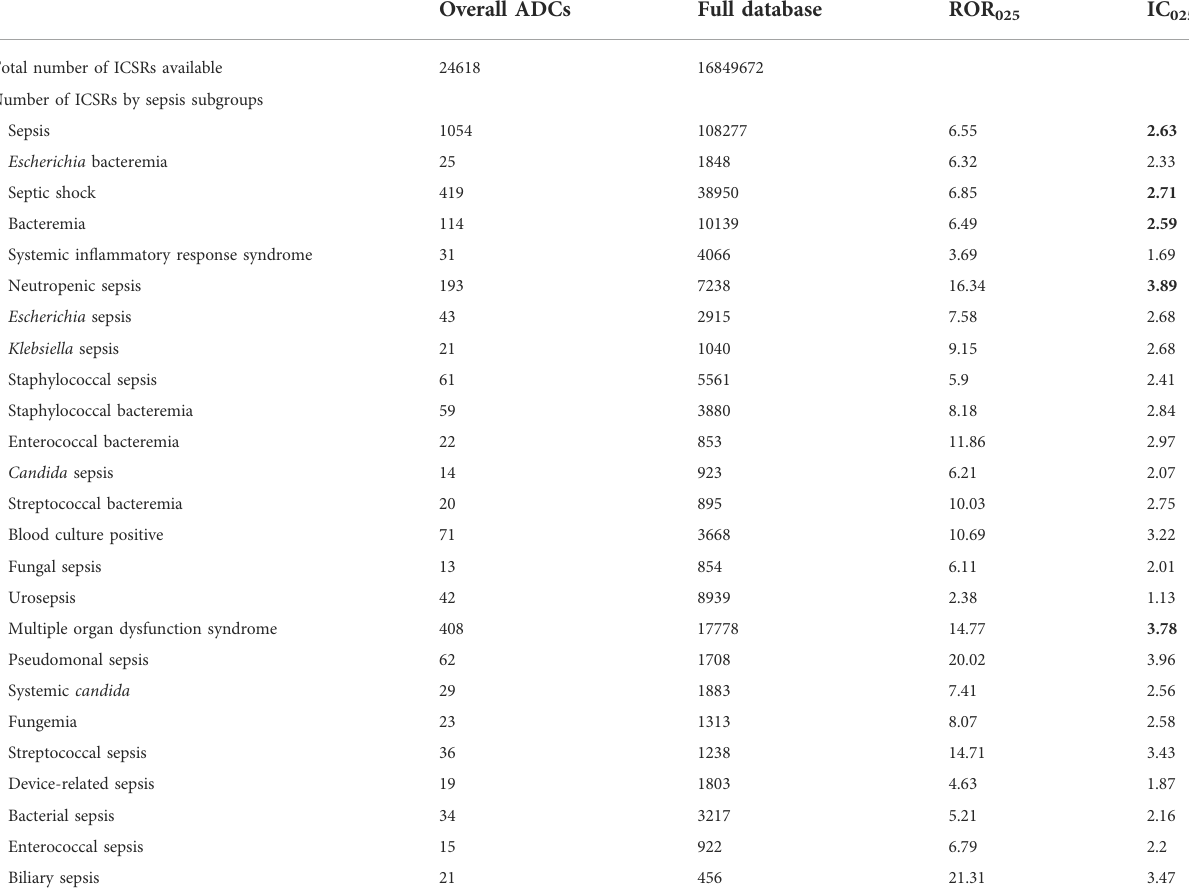
TABLE 1 Sepsis-related toxicities reported with ADC therapy vs. the full FAERS